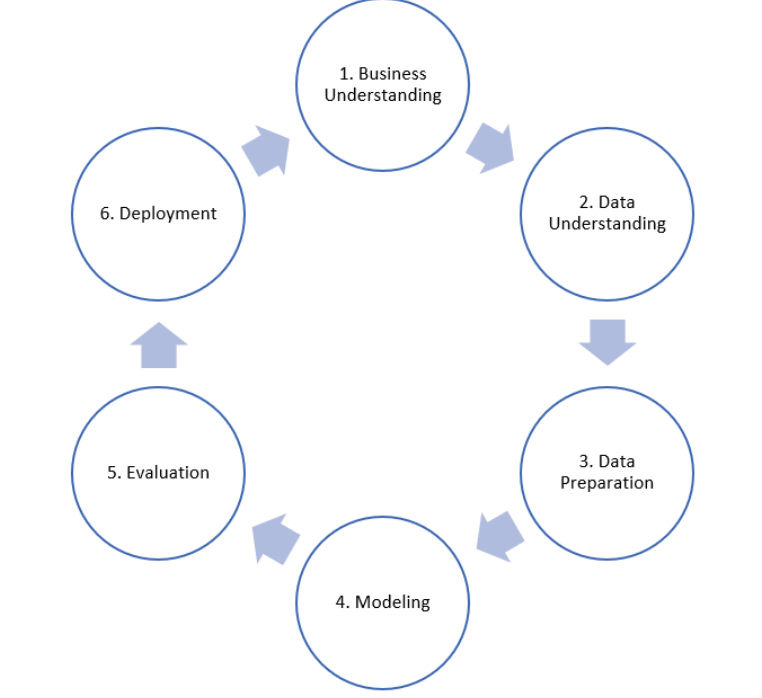
Figure 5. CRISP-DM Methodology adapted from